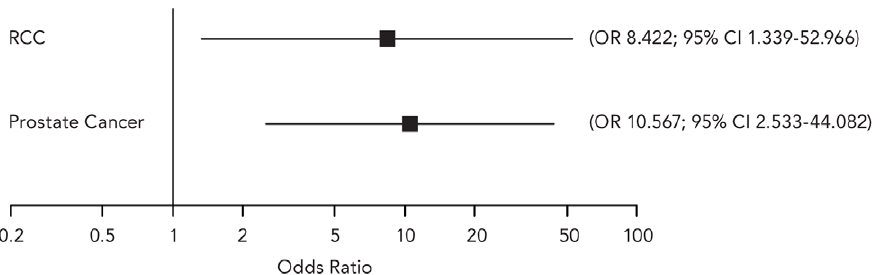
Figure 3. Meta-analysis of the odds ratio (OR) of cellular immune response and clinical benefit rate. Conditional logistic regression grouped by study using individual patient data revealed a statistically significant association between clinical benefit rate and induction of tumor antigen specific cellular immune response for prostate cancer and renal cell cancer (RCC) patients. Horizontal lines denote 95% confidence intervals.